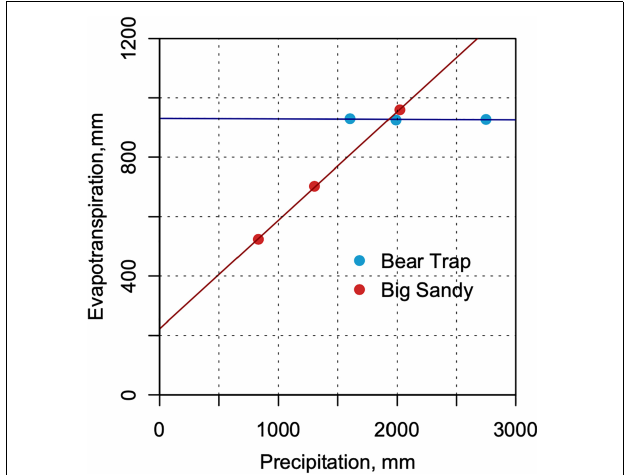
FIGURE 6 | Annual evapotranspiration as a function of dry to wet precipitation conditions in Bear Trap and Big Sandy. Forest vegetation was constant (pre-treatment), with fitted lines highlighting the different trends between the two